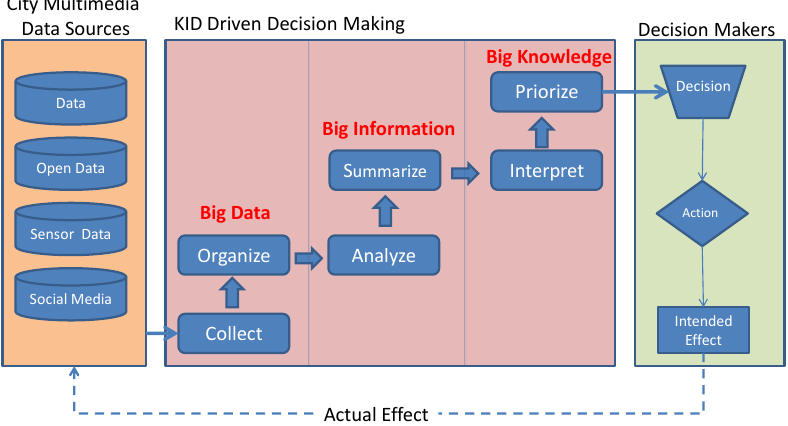
Figure 3. KID (knowledge, information, data) driven decision-making process in urban context. Different data sources available in the smart city should be properly processed to became valuable knowledge for decision makers.